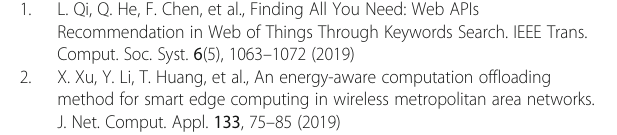
Table 1 Runtime in seconds under different dataset sizes Dataset